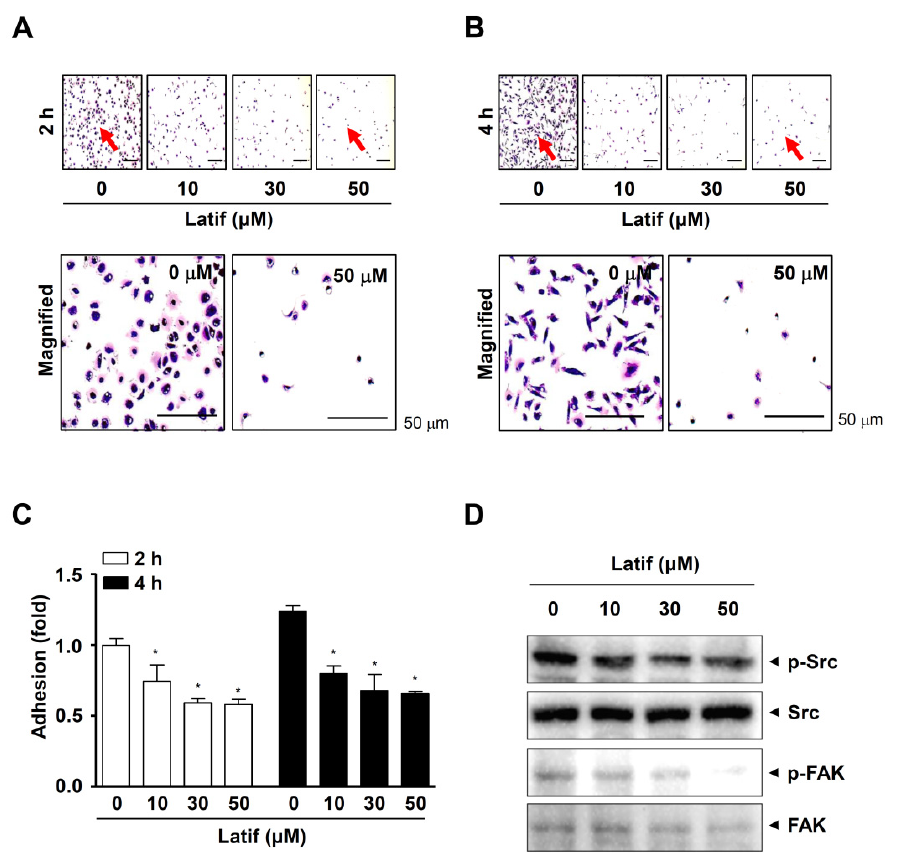
Figure 7. Effects of Latif on cell adhesion and FAK/Src signaling in human YD-10B OSCCs. ( A – C ) Latif-treated cells (10, 30, and 50 μ M) were seeded onto ECM-coated plates, and then the cell adhesion was monitored using a light microscope at the indicated time points, 2 h ( A ) and 4 h ( B ). Red arrows indicate the magnified region. The bar graph shows the relative value of cell adhesion (fold) normalized to the control ( C ). ( D ) Phospho-Src (p-Src), Src, phospho-FAK (p-FAK), and FAK were analyzed using Western blot analysis. Data are represented as mean ± S.E.M. Significance was set at p < 0.05, indicated by an asterisk in the graph.